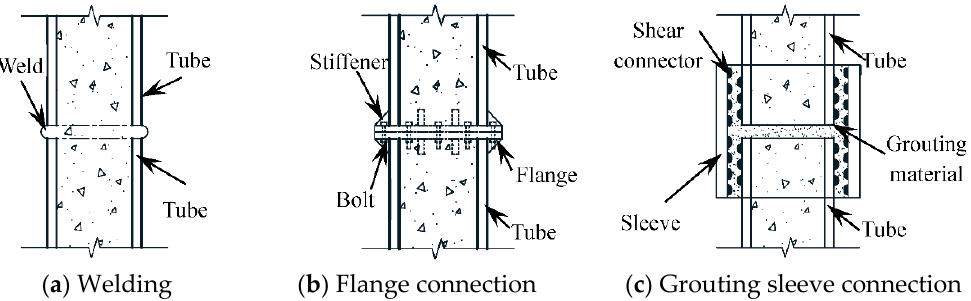
Figure 1. Common lengthening methods of steel tube of concrete filled steel tube.